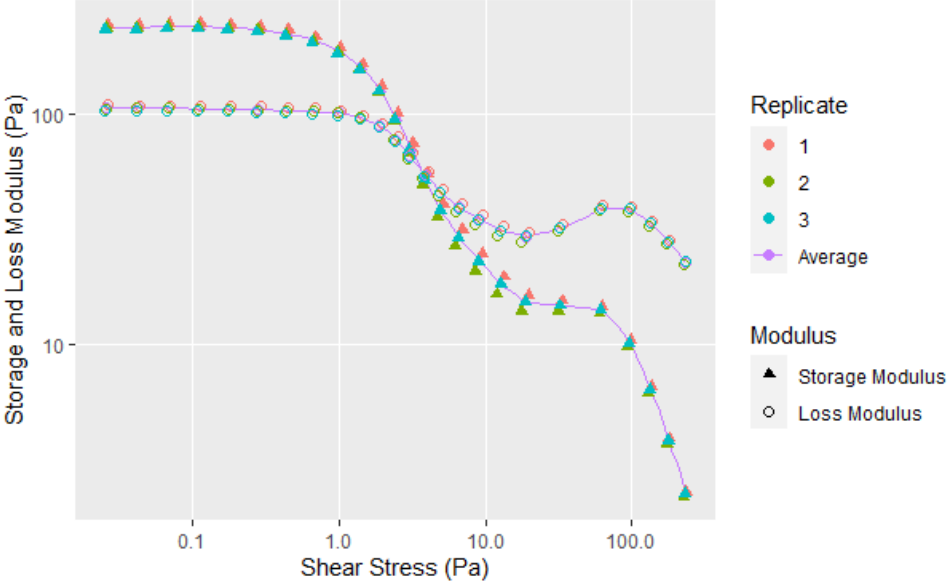
Figure A5. Individual amplitude sweep data for mixtures of 90 PDI flour with 1 h mixing time and 30% solid content.